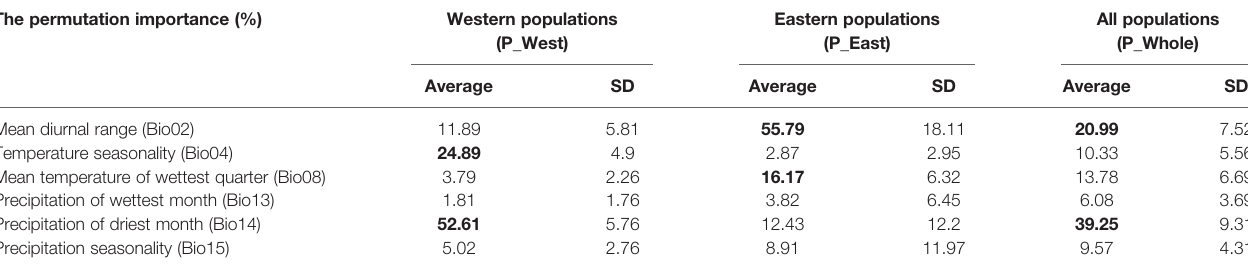
TABLE 2 | The permutation importance of the variables included in the MaxEnt models for Paeonia mairei . The permutation importance (%)